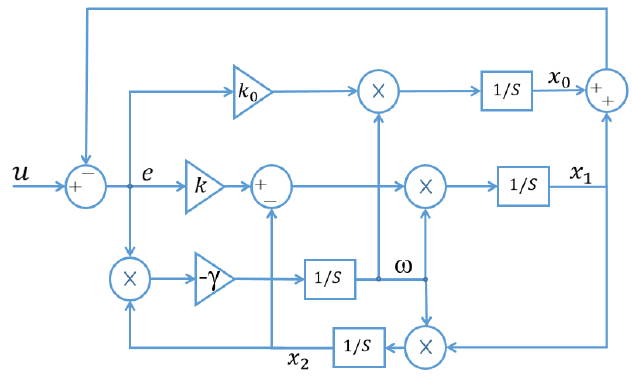
Fig. 2. Schematic diagram of the notch